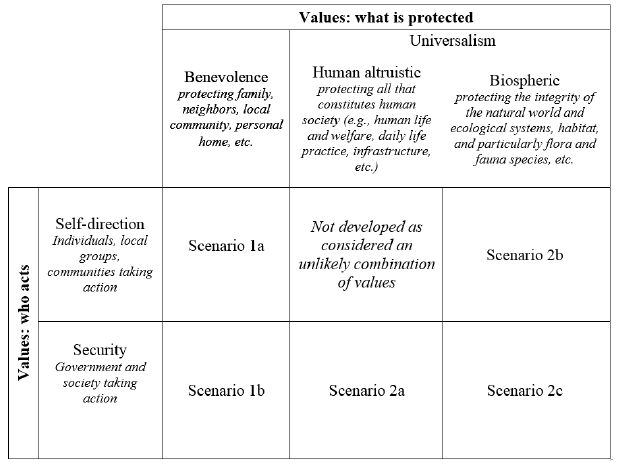
Fig. 3 . Application of the value-based scenario framework to bushfire and bushfire management in Victoria, Australia. We drew on research that indicated four core values (Schwartz 2012) are involved in value tensions for this context. The core values used in the application of the framework are benevolence, universalism, self-direction, and